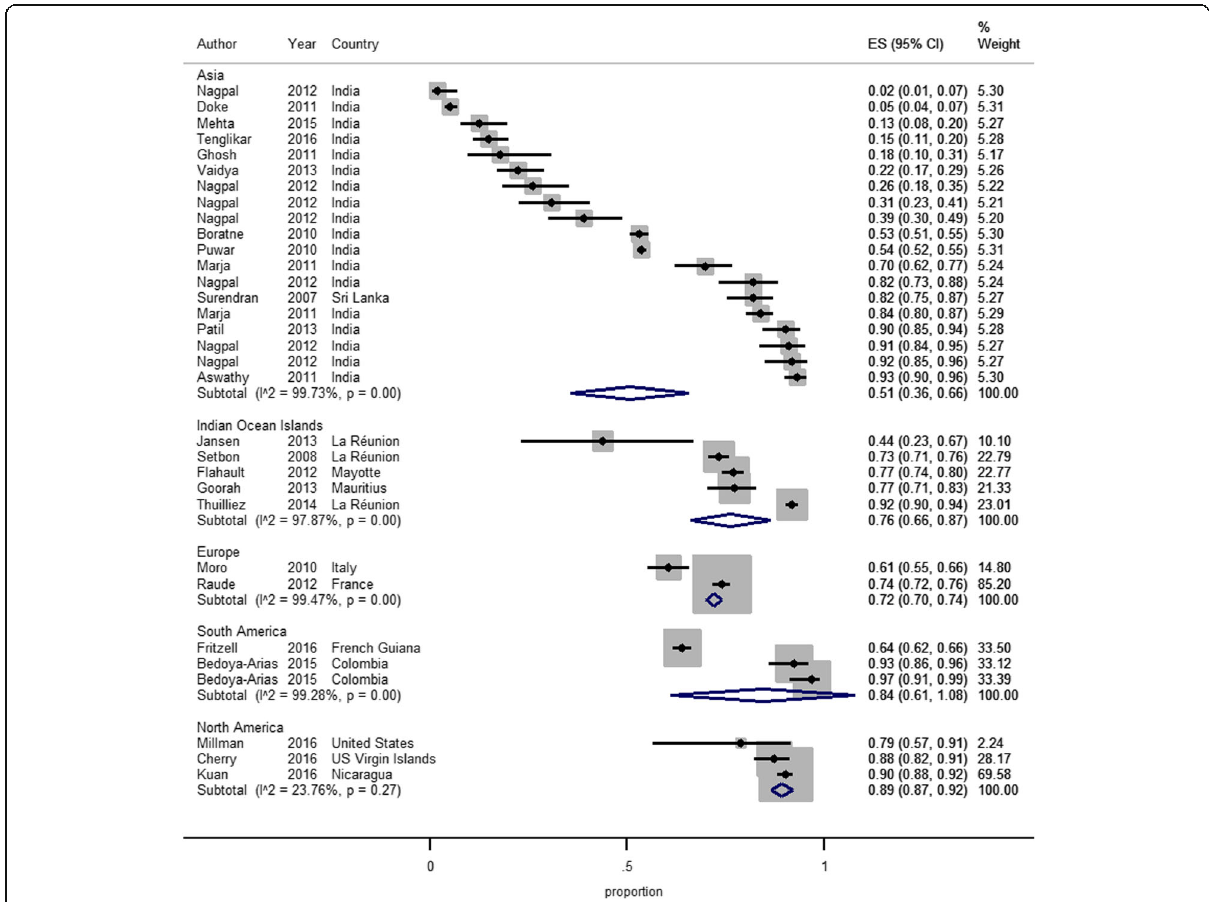
Fig. 3 Meta-analysis of the proportion (ES, 95% CI) of the sample population that had knowledge on mosquito transmission of CHIKV by